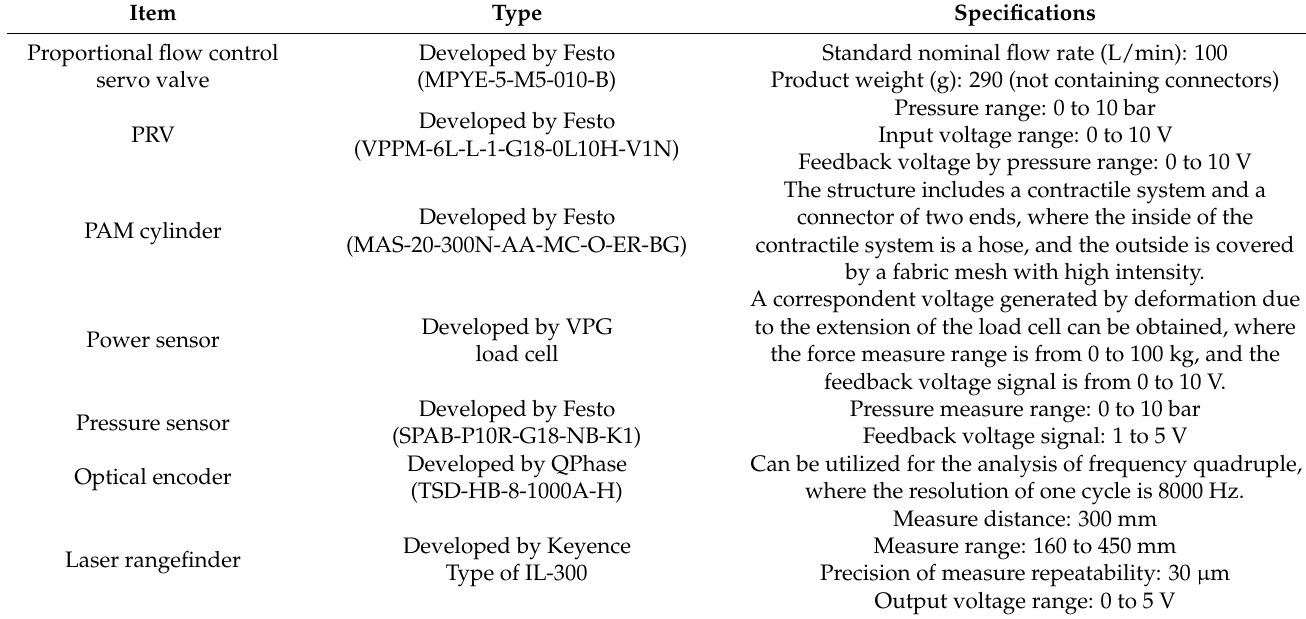
Figure 1. Structure of the electromechanical system of a robot arm. Table 1. Spec list of hardware and equipment used in this